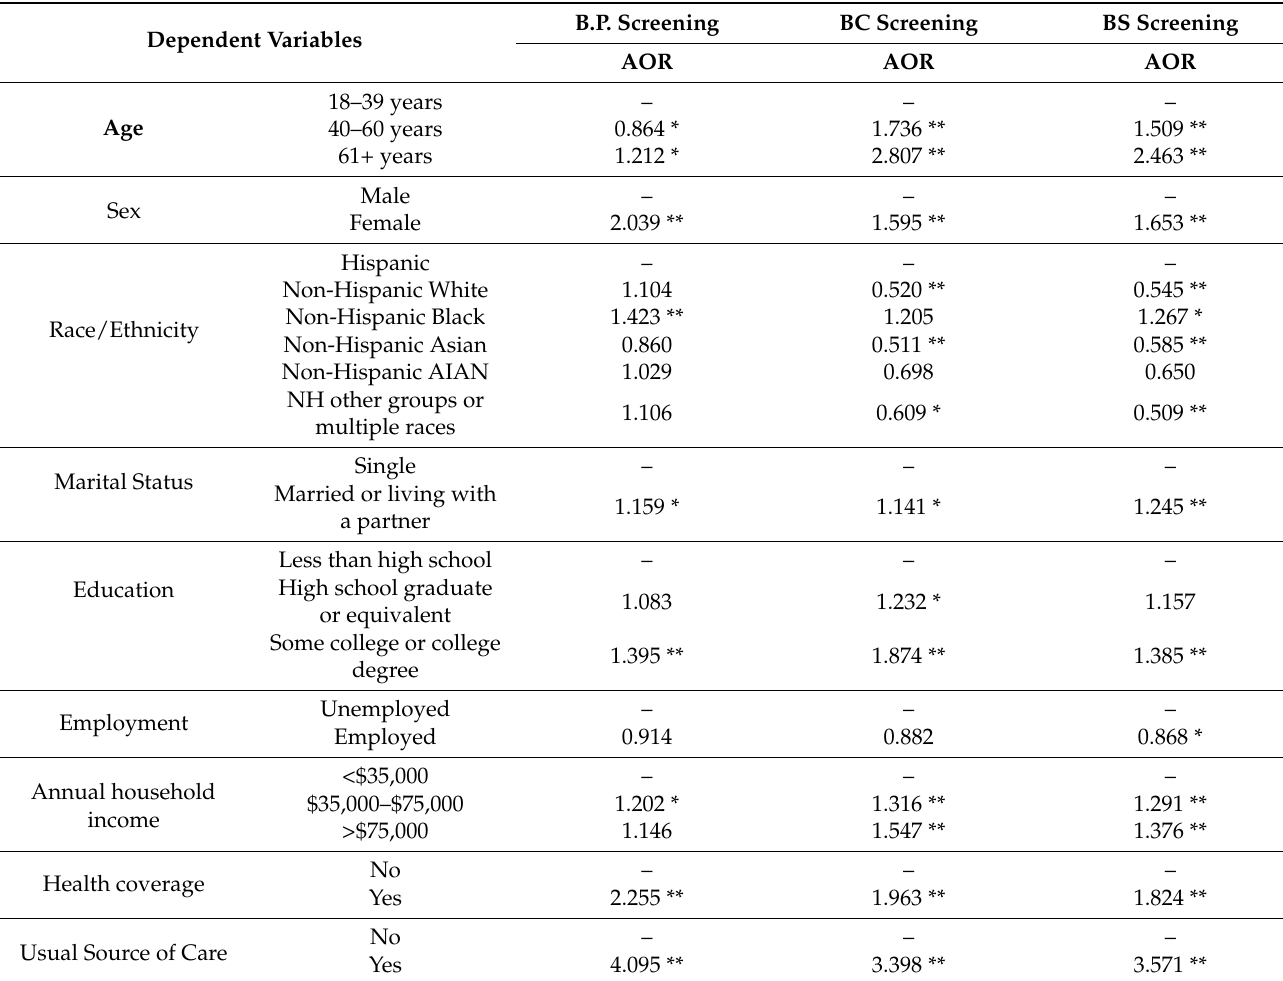
Table 3. Multivariate logistic regression analyses of sociodemographic characteristics associated with the utilization of hypertension, hypercholesterolemia, and diabetic screening among American adults: NHIS 2019. Dependent